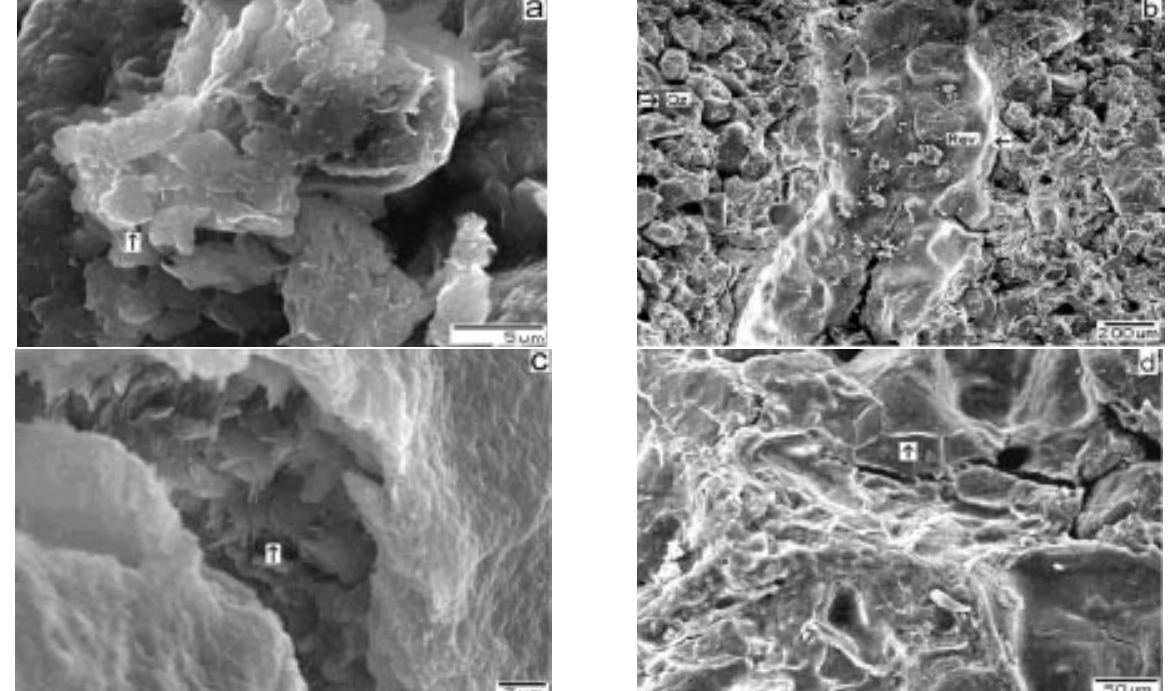
Figura 3. Micrografias do plasma argiloso caulinítico observado ao microscópio eletrônico de varredura: (a) argila ocupando os espaços intergranulares, com formato laminar no contato E/Bt (P1); (b) revestimento argiloso (Rev.) em poro tubular no topo do horizonte Bt (P2), mostrando material arenoso rico em quartzo (Qz) nas adjacências; (c) detalhe das argilas com disposição laminar em uma fissura correspondente ao revestimento encontrado na amostra “b”; (d) argilas no horizonte Bt2 (P1) mostrando aspecto moldado e fissuras, provavelmente decorrente do dessecamento e